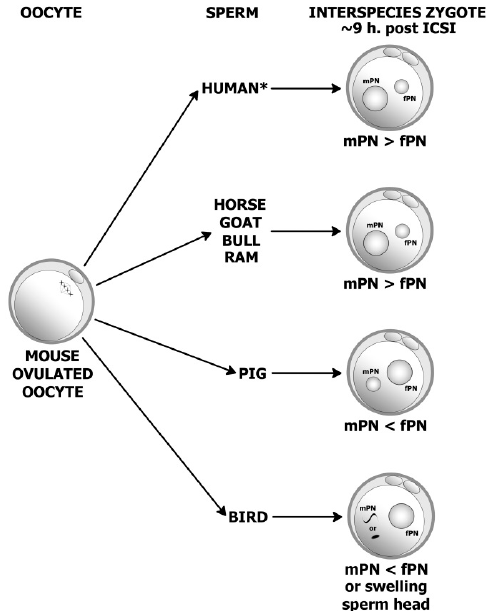
Figure 1. Decondensation of foreign sperm heads in ovulated mouse oocytes. Paternal pronuclei (mPNs) were always larger than maternal (female fPNs) when human, bull, horse, goat and ram spermatozoa were injected into ovulated mouse oocytes (* previous work: Fulka et al. [18]) and samples were evaluated approximately 9 h post ICSI. On the other hand, in the pig the mPNs were smaller than fPNs. When rooster spermatozoa were used for ICSI, no sperm head decondensation occurred (eventually only minor sperm head swelling was observed).